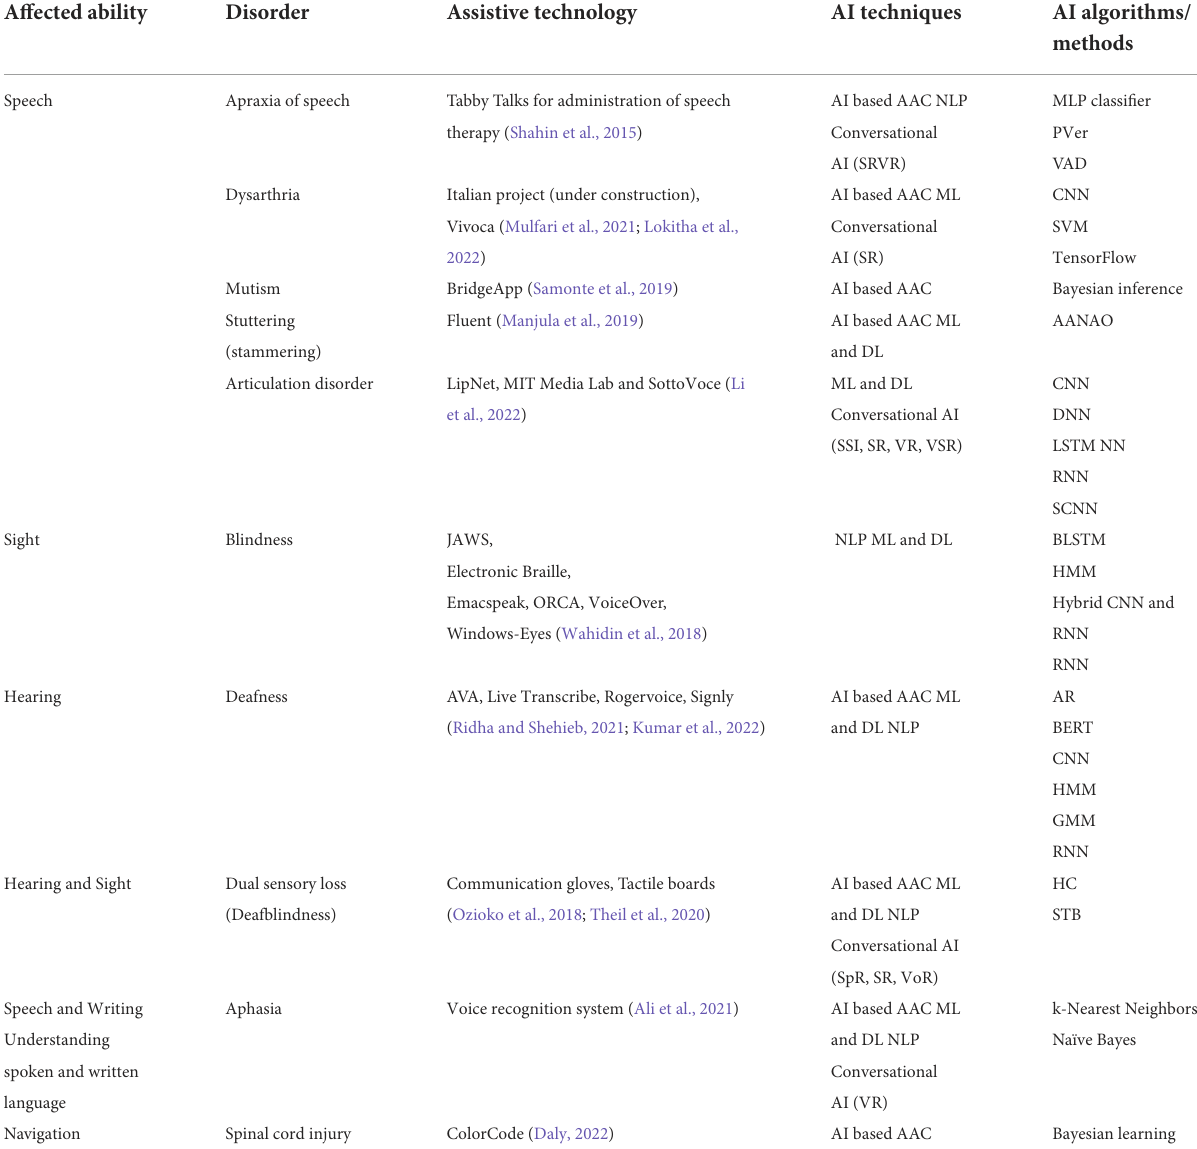
TABLE 1 Assistive technologies aligned to impaired communication